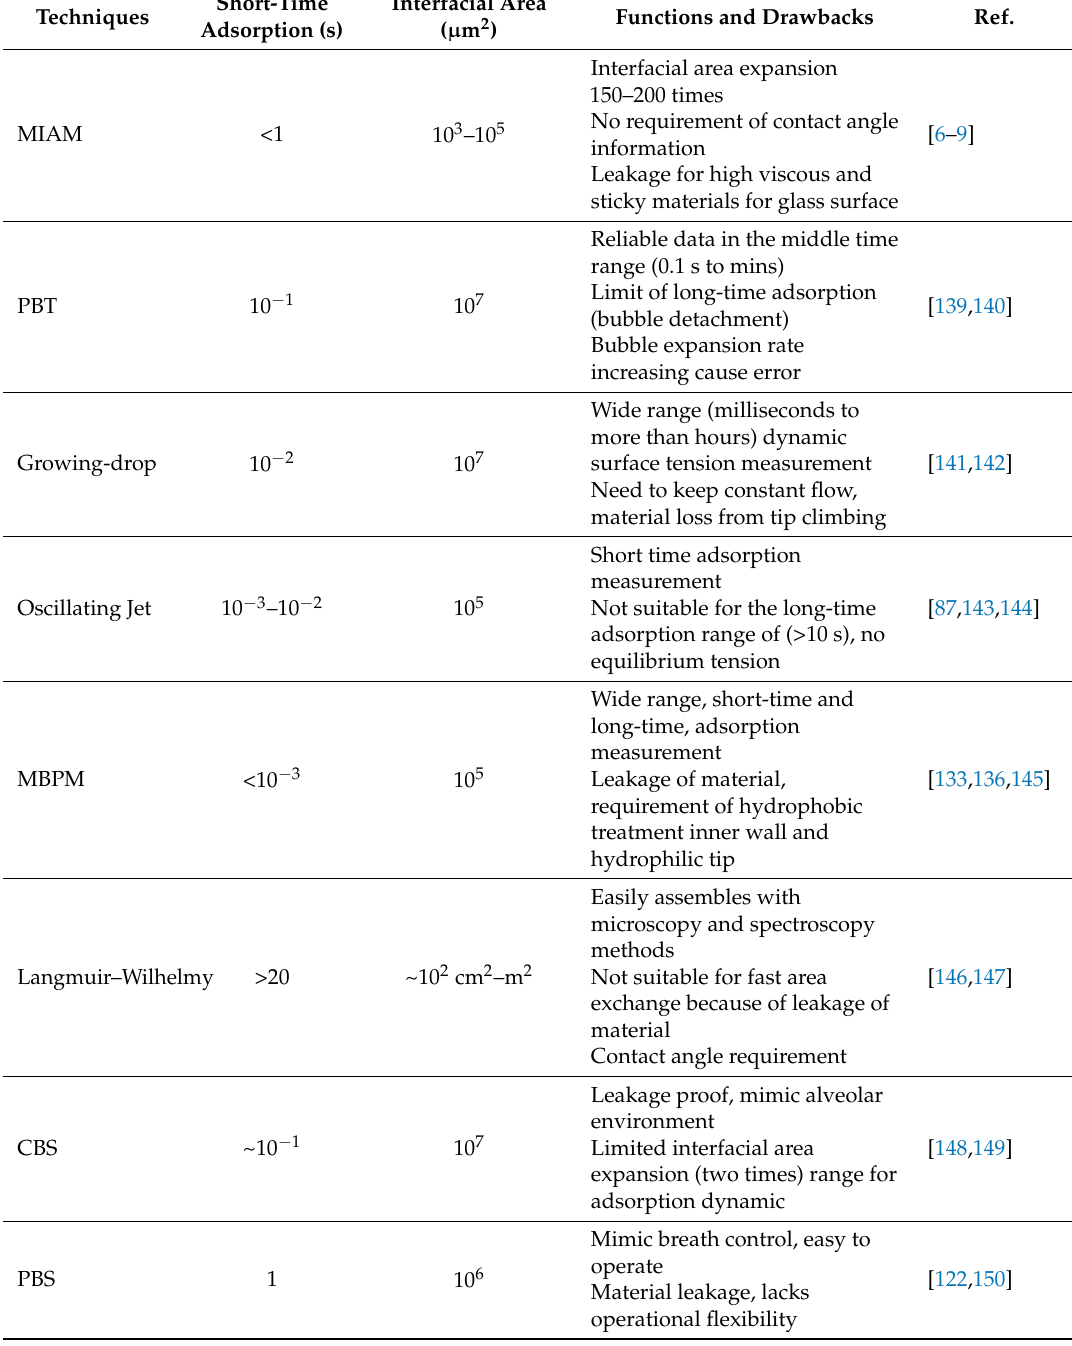
Table 2. Dynamic surface tension measurement techniques and their possible time-ranges for surfactant adsorption and area characteristics (adapted from Eastoe [135] and now including our new Micropipette Interfacial Area-expansion Method (MIAM)